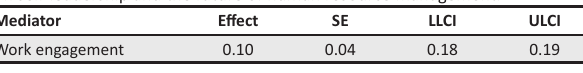
TABLE 5: Mediation – Complete standardised indirect effect of work engagement on self-leadership and the future of human resource management. Mediator